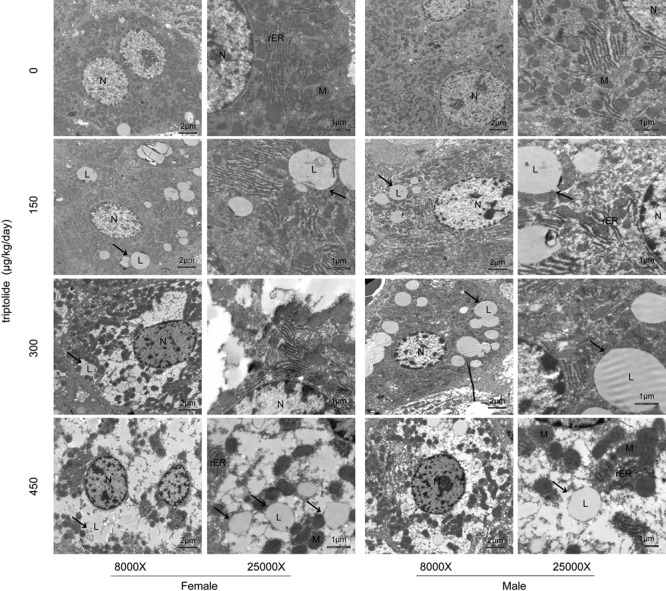
The results of electron microscopy examination of the liver following triptolide treatment (8000X and 25000X). Rats were administered 0, 150, 300, or 450 μg triptolide/kg/day by gavage for 28 days. Lipid droplets (L); mitochondria (M); rough endoplasmic reticulum (rER) and nuclei (N) are shown. More lipid droplets (arrow) were observed in the triptolide-treated female rats compared with the male rats.